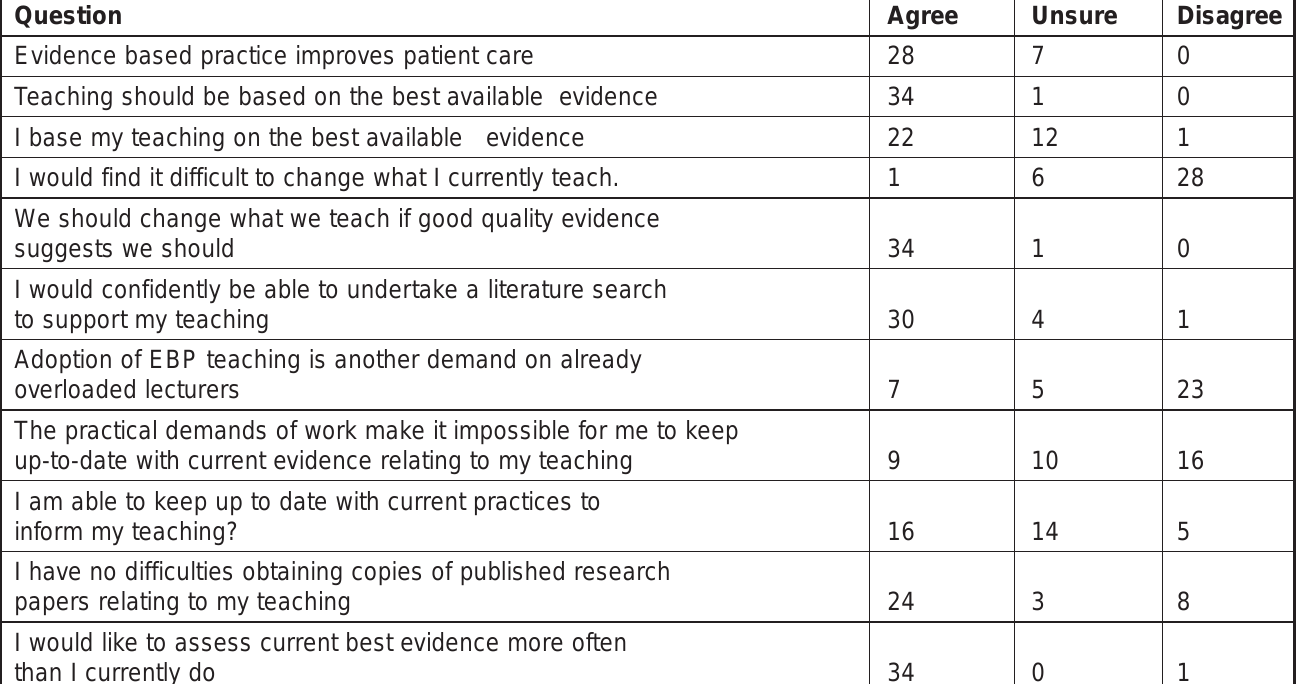
Table 2: Responses per question